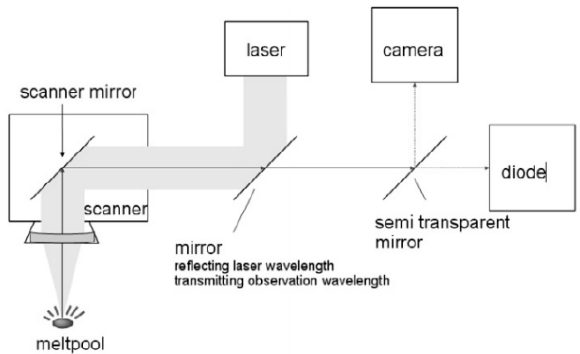
Figure 10. Schematic assembly of online process control [37].